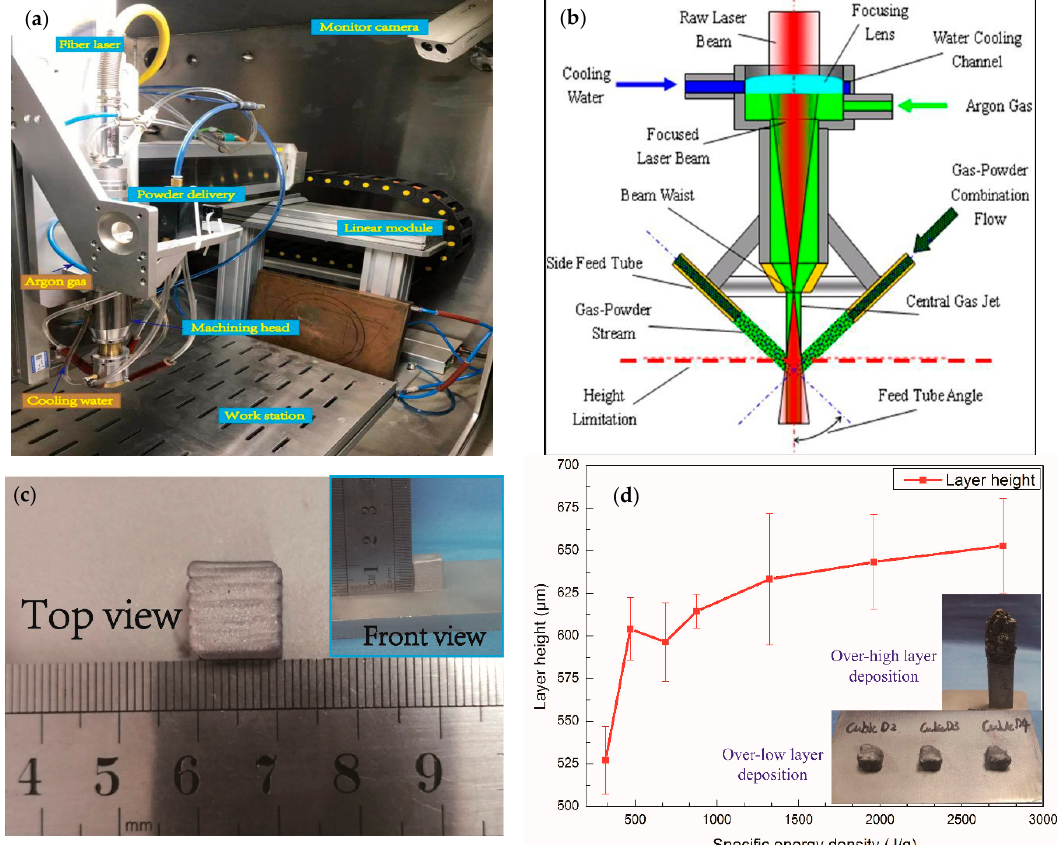
Figure 1. ( a ) The schematic of Laser metal deposition LMD processing assembly; ( b ) Structural sketch of machining head; ( c ) Macro-photograph of the deposited specimens; ( d ) The influence of specific energy density on actual layer height (bottom insert graph: the fail specimen with unreasonable parameters in previous work). Table 1. Nominal chemical composites of the Co21 alloy and substrate in wt.%. Co21 Content (wt.%)